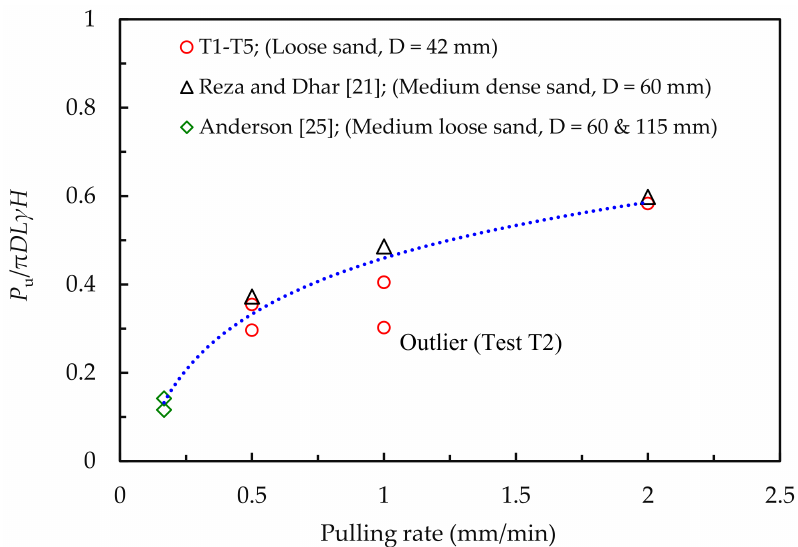
Figure 4. Normalized peak pullout forces with pulling rates in loose/medium